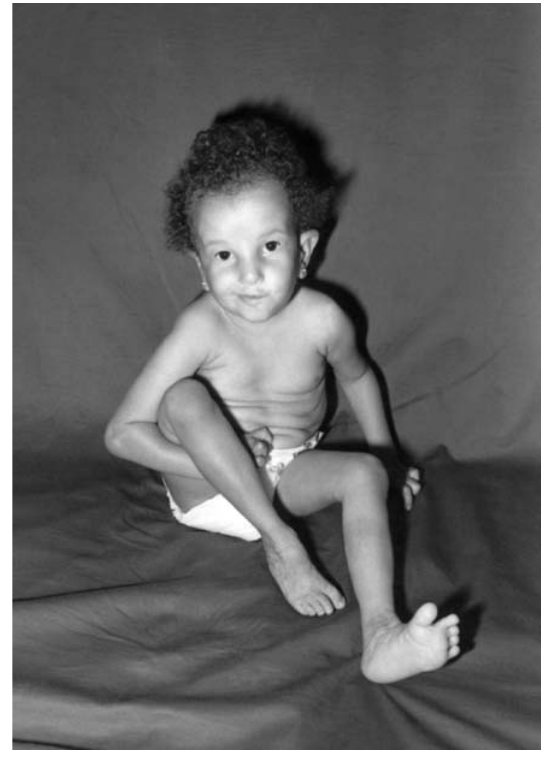
Figure 2 - Patient 1 at 10 years of age. Note the senile aspect of the face (A) and hands (B). Figure 3 - Patient 2 at 3 years of age, still unable to